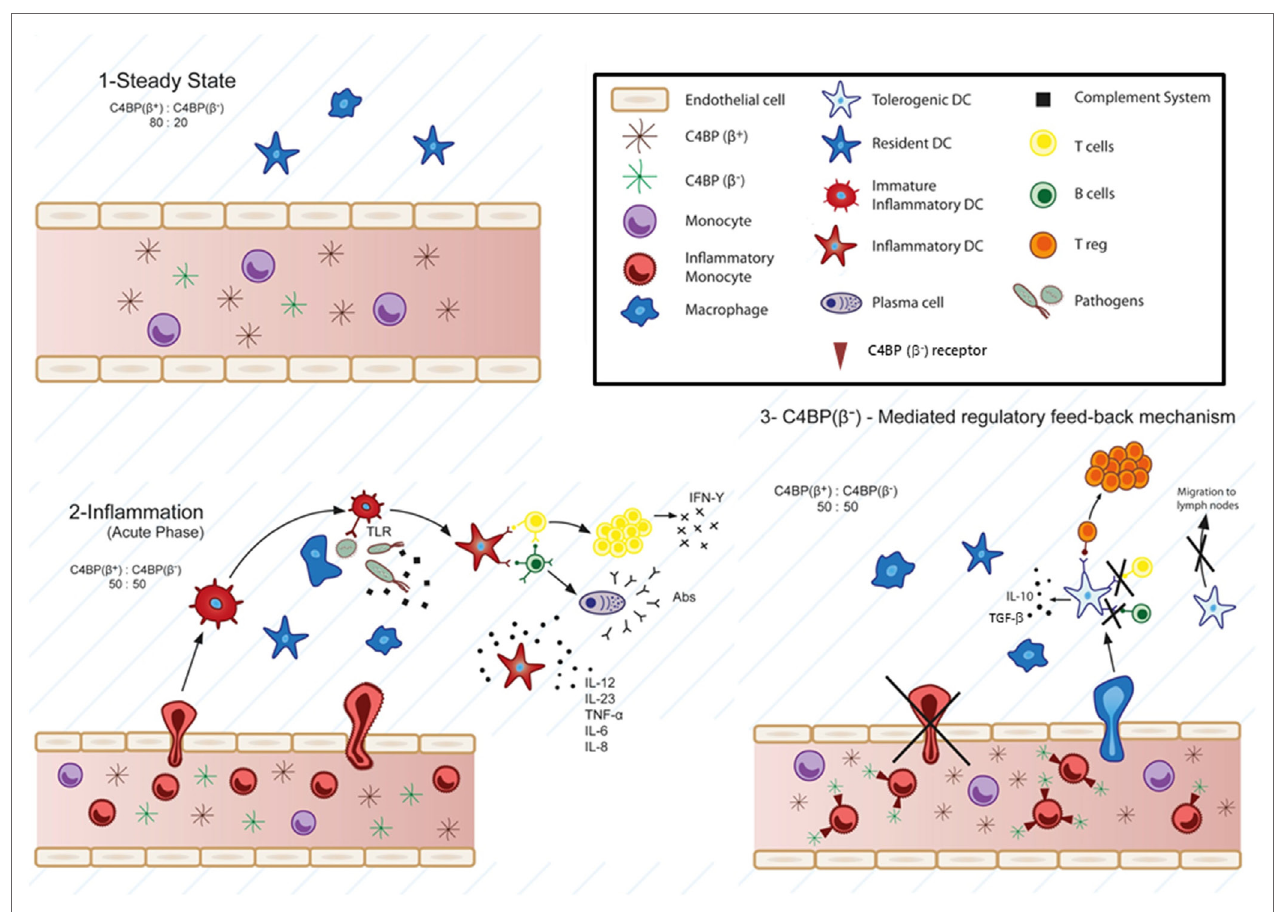
FiGURe 1 | Physiological involvement of C4b-binding protein (C4BP)( β− ) in cell-mediated immune-inflammatory responses. According to this model, at the steady-state, the classical and lectin pathways complement inhibitor C4BP circulates in two main isoforms: C4BP( β+ ) (80%) and C4BP( β− ) (20%) (1). Strong pro-inflammatory conditions (acute phase) induce a modification of the C4BP( β+ ):C4BP( β− ) ratio to 50:50, through increased levels of the acute phase protein C4BP( β− ) (2). Several evidences support a specific action of overexpressed C4BP( β− ) over inflammatory monocytes and monocyte-derived dendritic cells (DCs). Strong inflammatory stimuli (infection, lupus nephritis, etc.) trigger the presence of inflammatory monocytes in the blood, which are actively recruited to inflamed tissues, and differentiated to inflammatory DCs, having the ability to stimulate naïve T cells. Under these conditions, besides its function as complement inhibitor, the increased presence of C4BP( β− ) in the blood would act in one or both ways upon engaging one or some, as yet unknown, cell surface receptor(s): 1) reducing transendothelial migration and accumulation of the inflammatory monocytes into the inflamed tissue and 2) inducing a tolerogenic phenotype in the recruited inflammatory DCs, which would led to: (a) inhibition of T cell proliferation and differentiation into Th1, Th2, and/or Th17 cells depending on the inflammatory microenvironment, (b) decreased pro-inflammatory cytokine secretion (IL-12, TNF- α , IFN- γ , etc.), (c) reduced migration to the lymph nodes, and conversely, to: induction of anti-inflammatory cytokine release (IL-10, TGF- β , etc.), and (d) Treg generation within the inflamed tissues